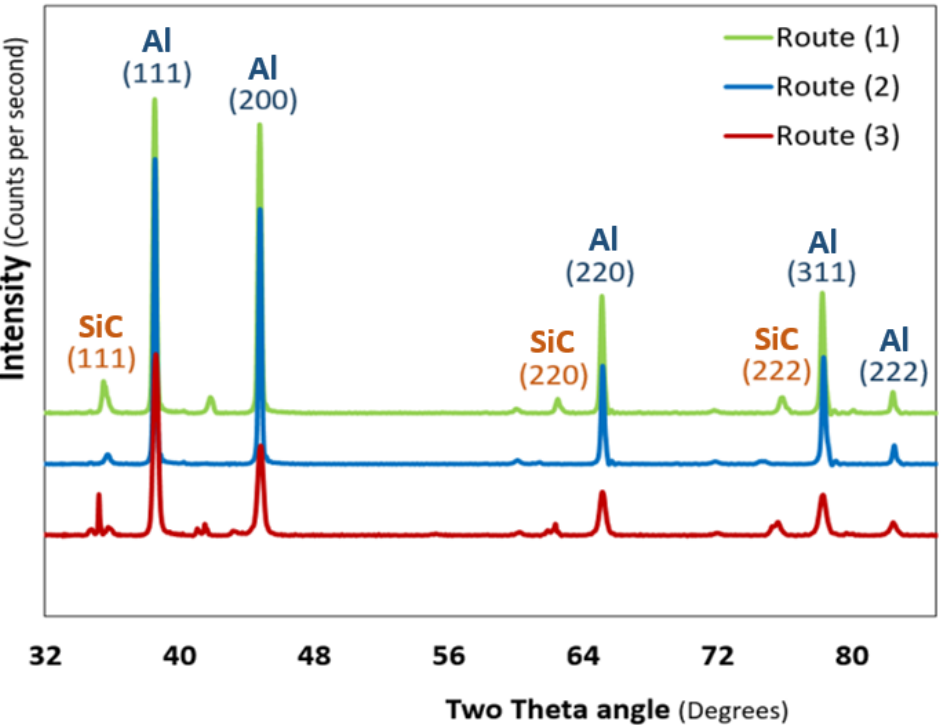
Figure 2. XRD patterns collected for first Al-SiC (Route (1)), second Al-SiC (Route (2)), and third Al-SiC (Route (3)) bulk nanocomposites.